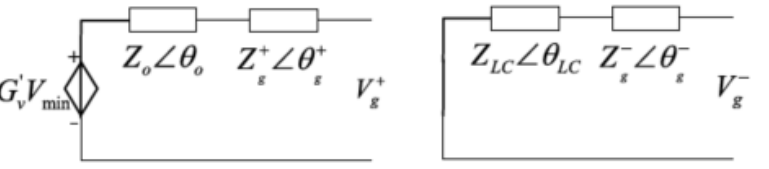
Figure 2. Positive ( left ) and negative ( right ) sequence equivalent circuits of droop-controlled inverter with droop limiters [34].